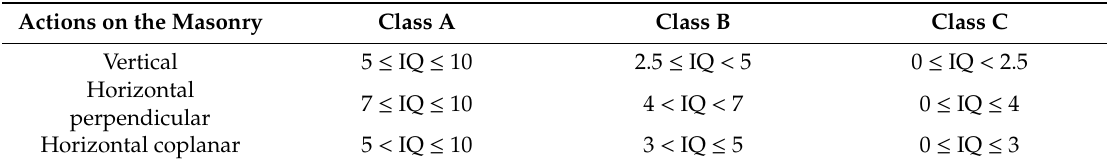
Table 1. Attribution of masonry category.